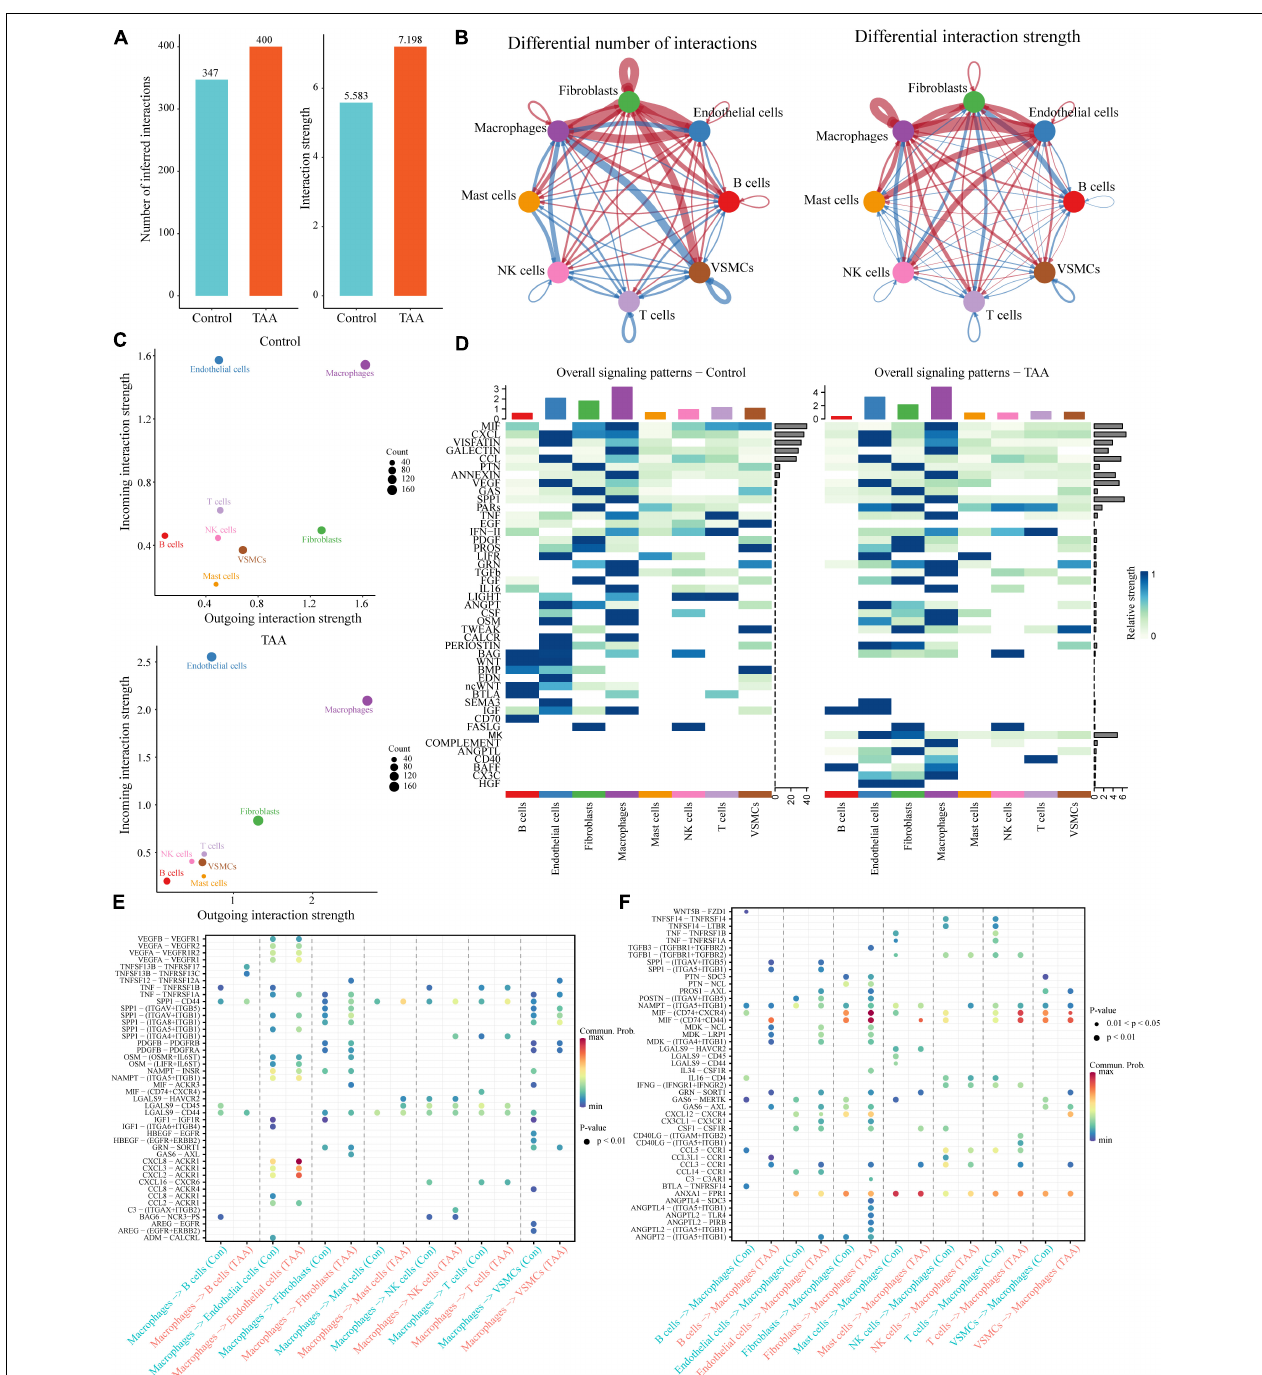
FIGURE 5 | Inference of the cell-cell communications among the identified cells in TAA. (A) CellChat analysis indicates the increase in inferred interactions (number of interactions and interaction strength) among the cells in TAA. (B) Overview of the intercellular communication networks among the identified cell lineages was measured by network centrality analysis. Nodes with different colors represent different cell populations, and the red (blue) edge represents an increase (decrease) in the number of interactions or interaction strength in TAA compared with controls. (C) Scatter diagram showing the macrophages as the most prominent signal senders and receivers in TAA and control samples. (D) Heatmaps showing the relative strength of 45 signaling pathways among the eight cell populations in the overall signaling patterns. A gradual change in the color from blue to white indicates the change in the relative interaction strength from high to low. (E,F) The significant ligand-receptor pairs between TAA and controls are shown in dotplots, which contribute to the signaling from macrophages to other cells, including B cells, endothelial cells, fibroblasts, mast cells, NK cells, T cells, and VSMCs (E) , or from other cells to macrophages (F) . Dot color reflects communication probabilities and dot size represents computed P